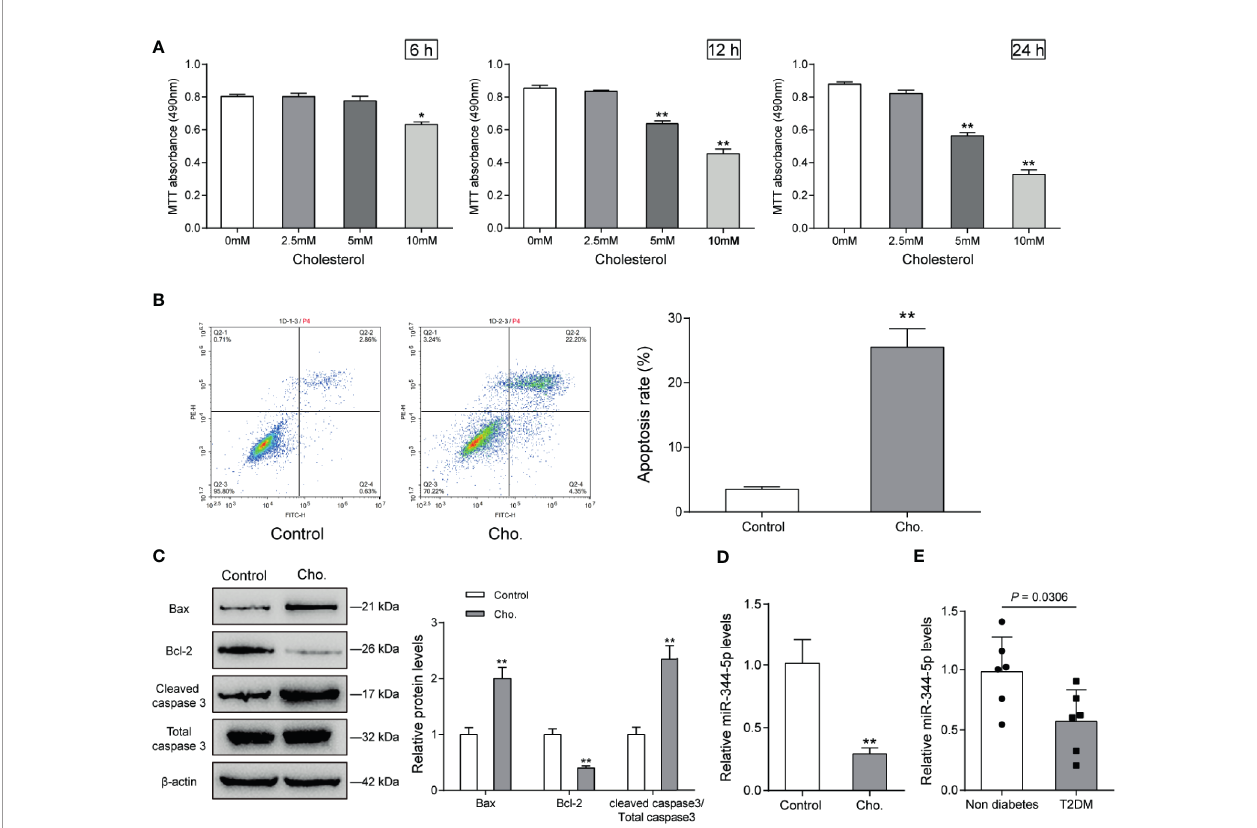
FIGURE 1 | Cholesterol-induced cytotoxicity on rat pancreatic b -cell INS-1 cells. (A) INS-1 cells were treated with 0, 2.5, 5, or 10 mM cholesterol for 6, 12, or 24 h for high-fat induction and examined for cell viability by MTT assay. Then, INS-1 cells were treated with 5 mM cholesterol for 12 h and examined for the cell apoptosis by Flow cytometry assay (B) ; the protein levels of Bcl-2, Bax, and cleaved-caspase 3 by Immunoblotting, b -actin was applied as an endogenous control (C) ; the expression levels of miR-344-5p by real-time PCR (D) . (E) The expression level of miR-344-5p in pancreatic tissues of patients with type 2-diabetes (n=6) and none- diabetes patients (n=6) was detected by real-time PCR. * P < 0.05, ** P <